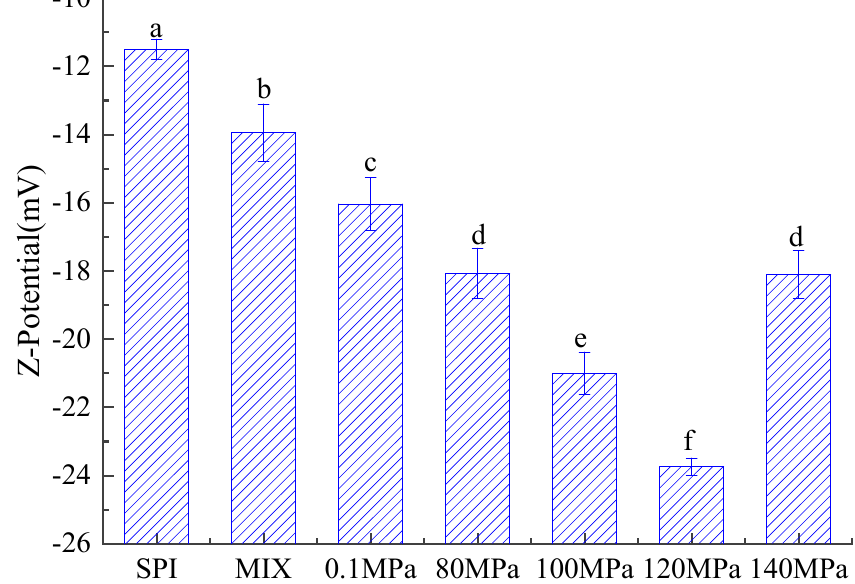
Figure 12. Zeta potential of emulsions created with the samples. SPI is the native soy protein isolate; MIX represents the mixture of SPI and GOS; 0.1 MPa represents the traditional wet heating Maillard reaction group; 80 MPa, 100 MPa, 120 MPa, and 140 MPa are the HPH treatment groups. The letters (a–f) indicate decreasing orders of magnitude ( p < 0.05).